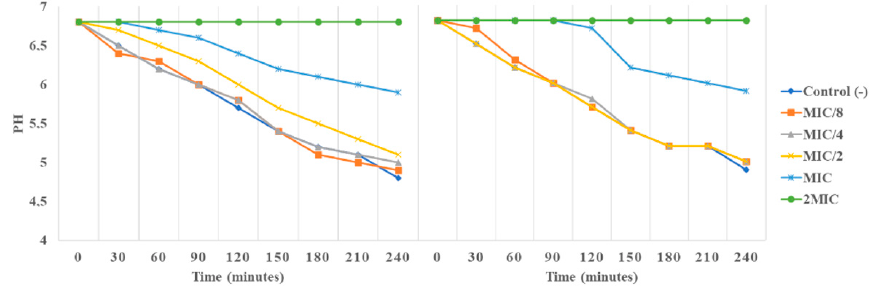
Figure 10. The action of optimized ethanolic bark extract of Enantia chlorantha ( A ) and AgNPs ( B ) on E. coli ATCC 25922 H+-ATPase-mediated proton pumping. MIC = minimum inhibitory concentration.